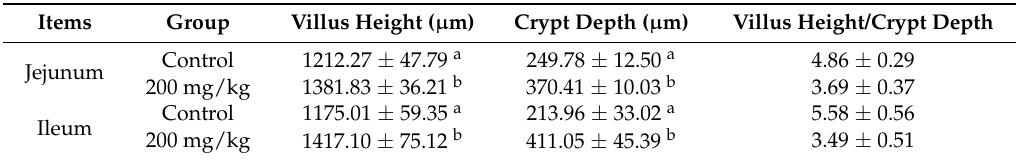
Table 4. Effect of L -theanine on villus height and crypt depth.